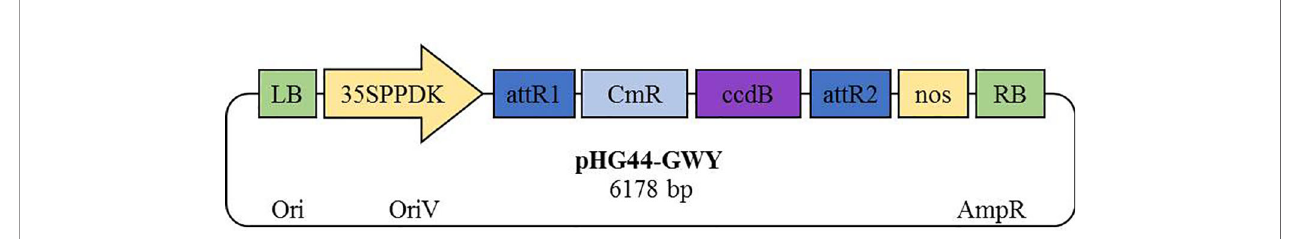
FIGURE 1 | Principal elements of the Gateway-modi fi ed gene expression vector pHG44-GWY. The binary vector pHG44 was modi fi ed to carry a Gateway cloning cassette with the ccdB suicide gene and attR recombination sites along with the promoter 35SPPDK and nos terminator between its left and right border repeats from nopaline C58